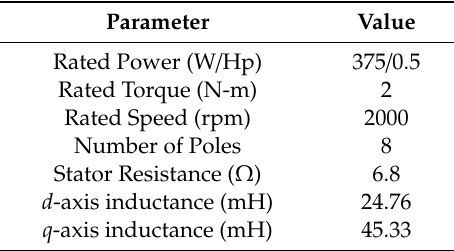
Table 3. IPMSM specifications.